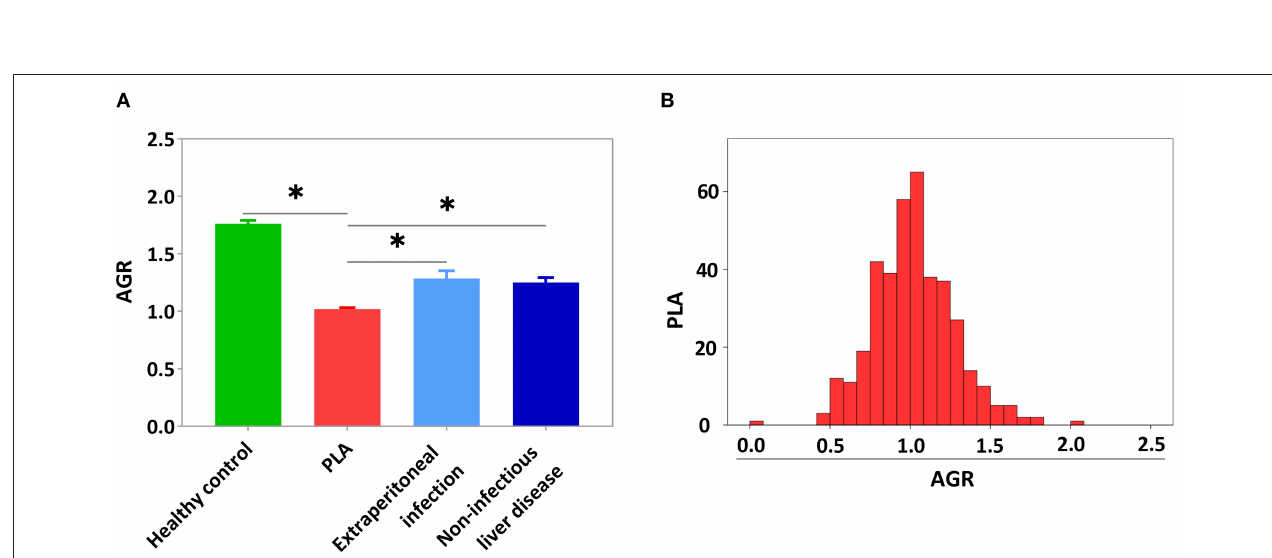
FIGURE 2 | The PLA patients had lower AGR level compared with the healthy controls and the patients with extraperitoneal infection or non-infectious liver disease. (A) The AGR levels in healthy controls and the patients with PLA, extraperitoneal infection and non-infectious liver disease. (B) The AGR distribution of PLA patients. Data were presented as the mean ± SE. Differences between the groups were compared by the One-way ANOVA. * P < 0.05.